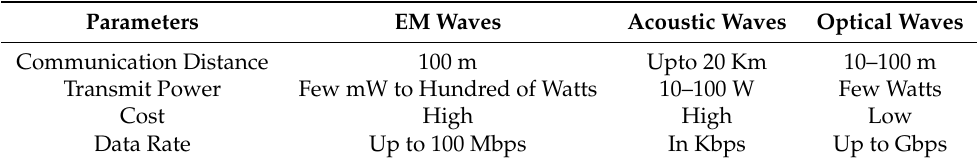
Table 1. Underwater wireless communication channels